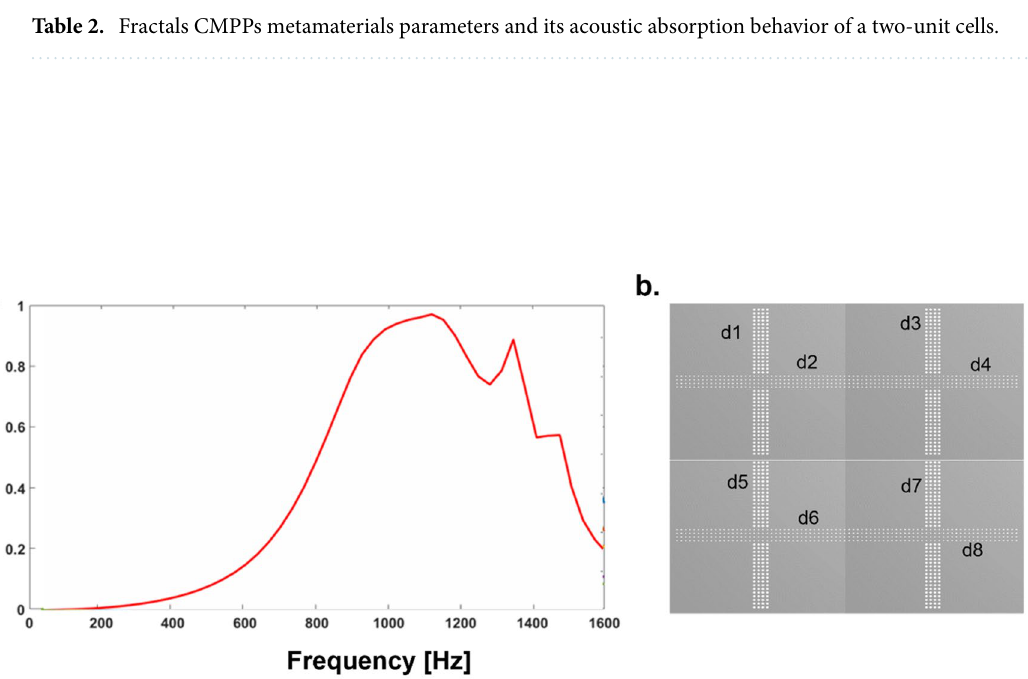
Figure 5. Four-unit cells with different cross perforation. ( a ) Sound absorption coefficient of combined four- unit cells with different cross porosity. ( b ) Top view of the samples of four-unit cells. Courtesy (ANSYS 17.0 45 and MATLAB R2016a 46